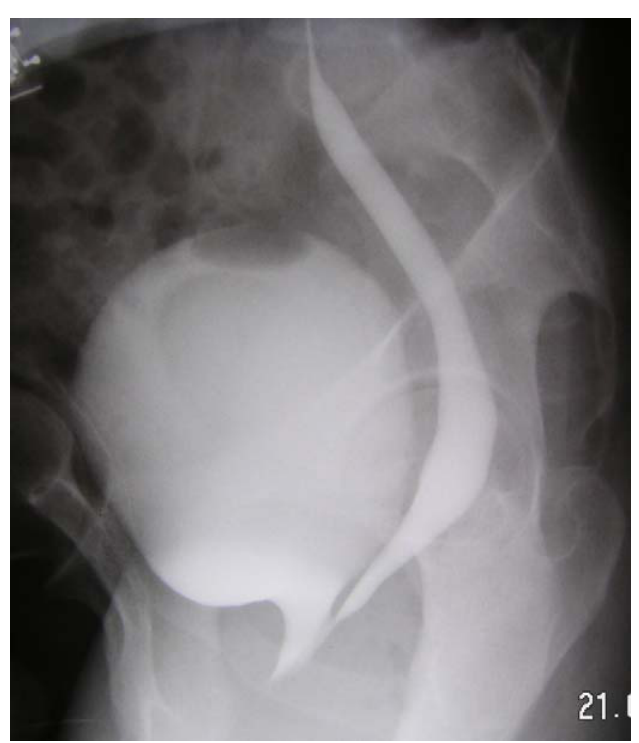
FIGURE 2. Preoperative Micturiting